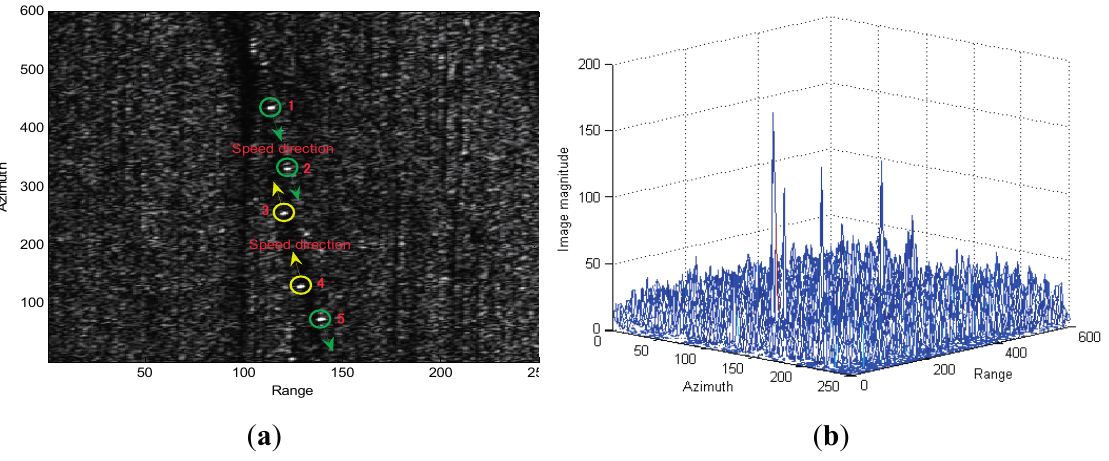
Figure 6. Measured dual-channel SAR scene: ( a ) The fore-channel SAR image; ( b ) The visible display of